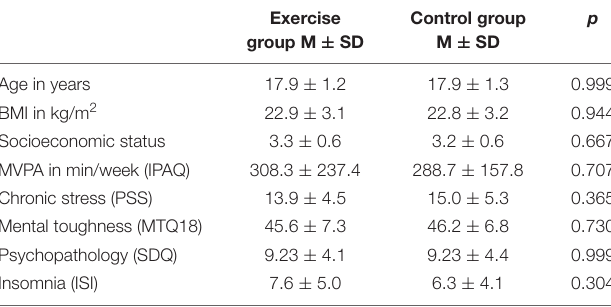
TABLE 1 | Comparison of group characteristics (independent T